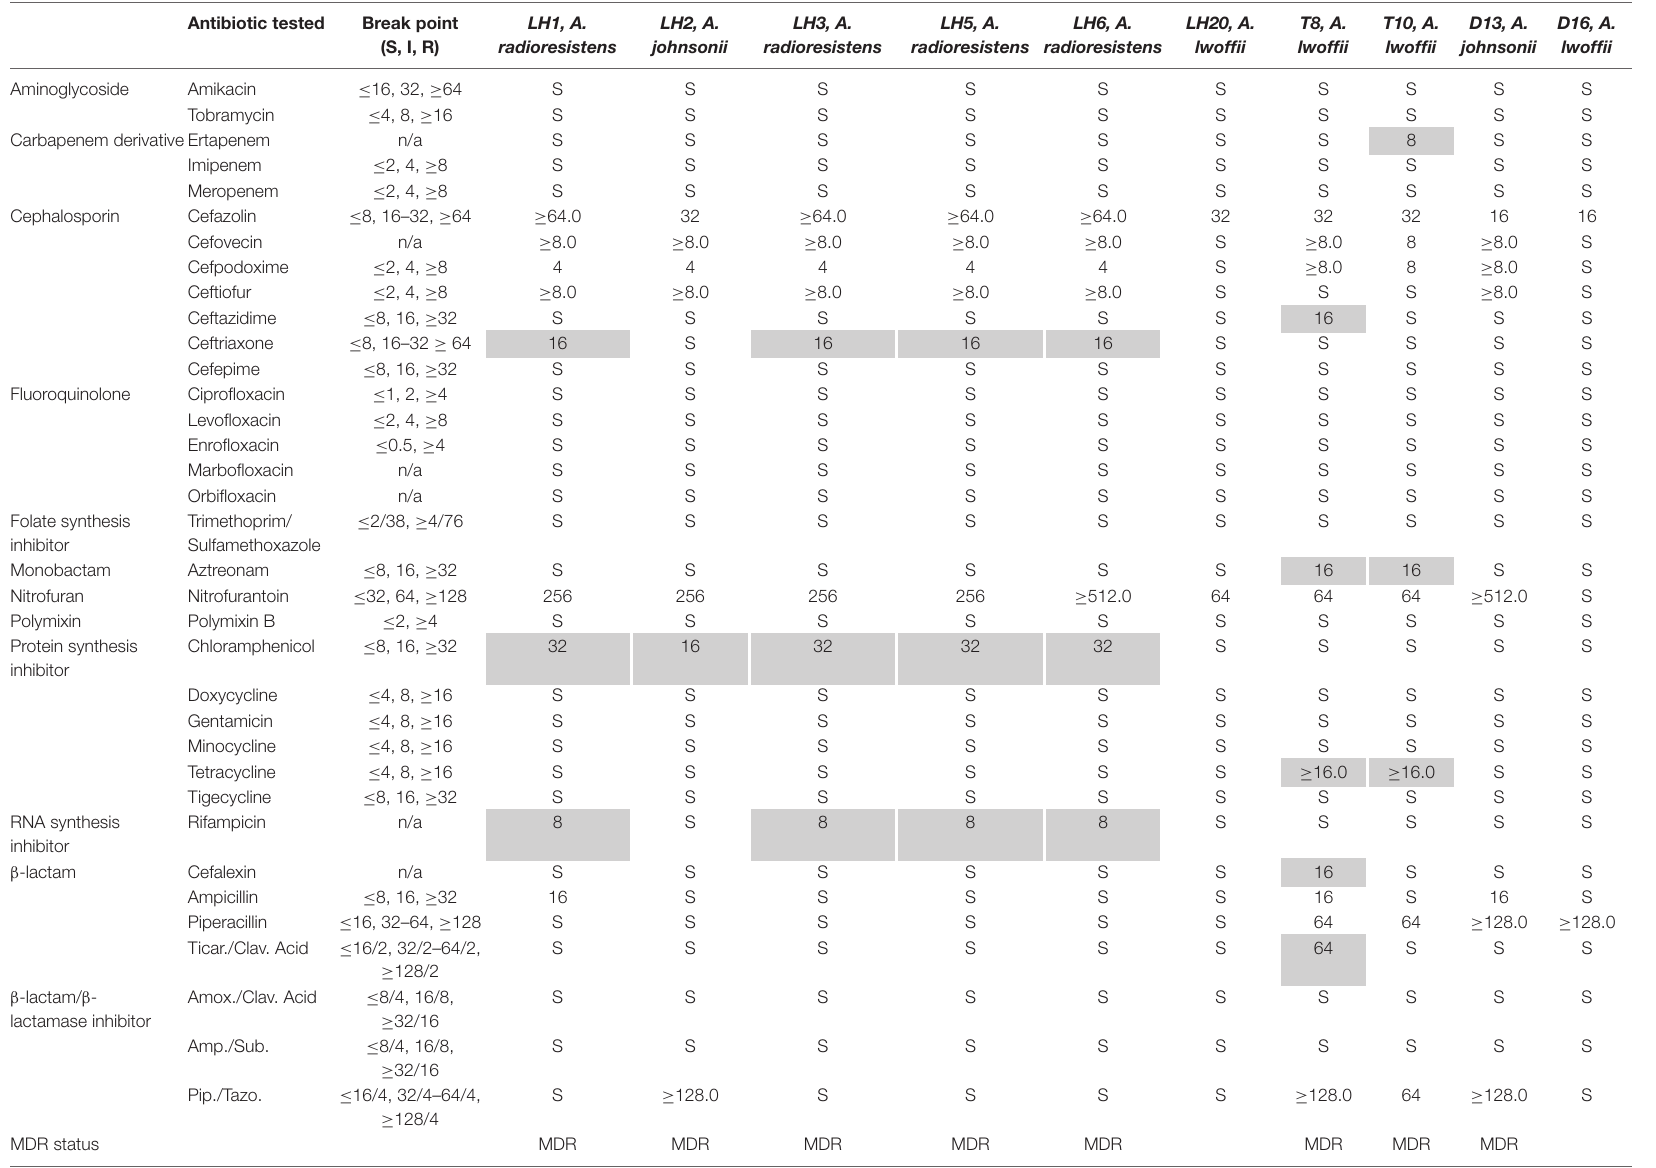
TABLE 1 | Strain identification and minimum inhibitory concentrations of antibiotics for each Acinetobacter species isolated from avian fecal